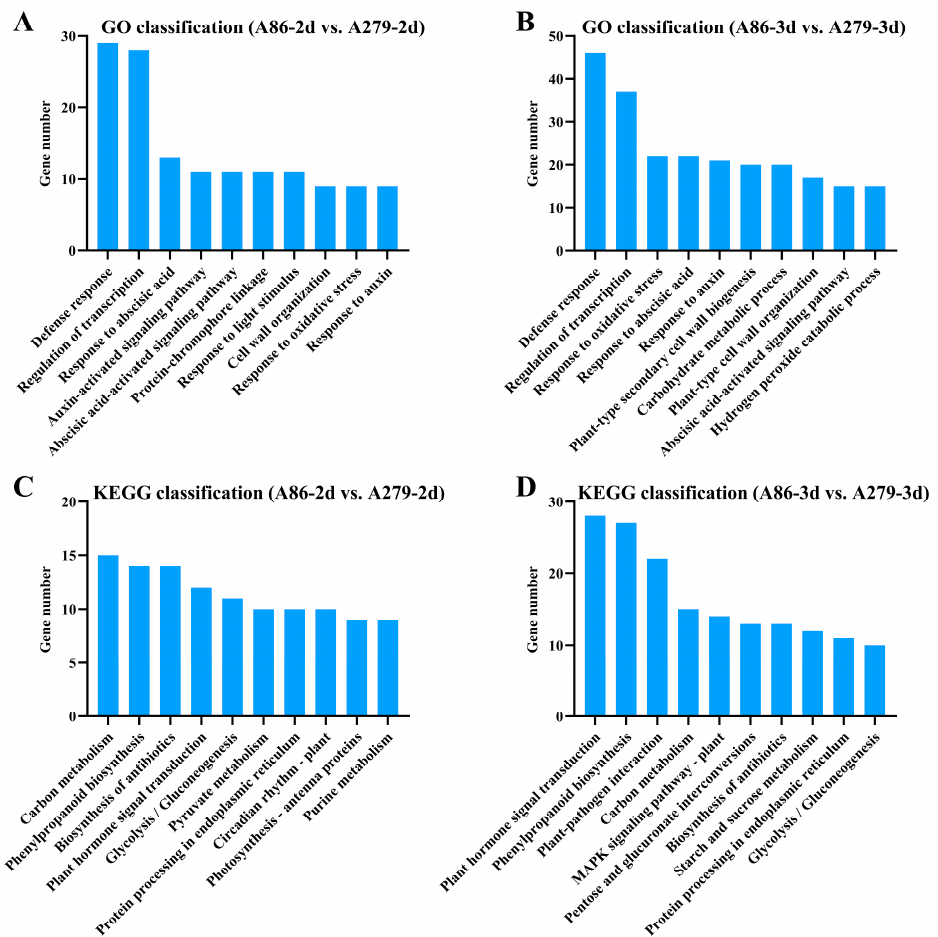
Figure 3. The functional GO and KEGG pathway classification of the DEGs. ( A , B ) The main GO terms of the DEGs between A86 and A279 at each time point. ( C , D ) The main KEGG pathways of the DEGs between A86 and A279 at each time point.